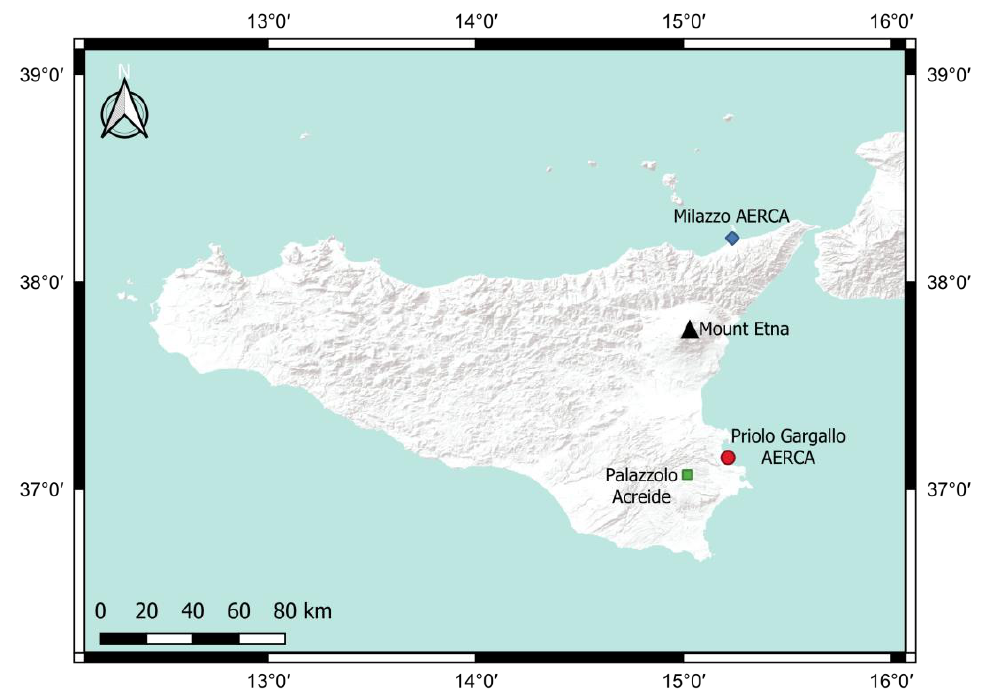
Figure 1. Localization of study areas. Base map: ESRI Terrain. Coordinates in degrees and minutes (reference system: EPSG 4326).